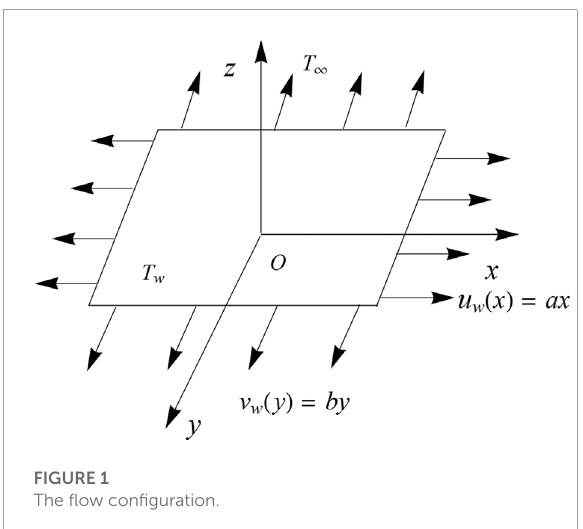
FIGURE 1 The flow